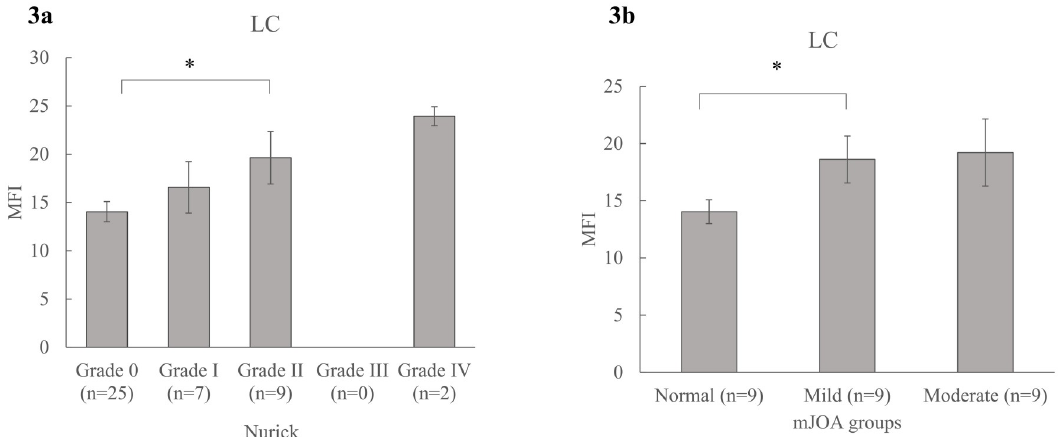
Fig 3. Association between MFI and clinical scores. Mean group differences in MFI across varying severity of clinical disability in patients with DCM as measured by a) Nurick (Grade 0—IV), and b) mJOA groups (Normal = 18, Mild = 17–15, and moderate = 14– 12). Mean (SE) are reported. � denotes significance at p � 0.05. MFI = muscle fat infiltration, LC = longus colli and longus capitis, mJOA = modified Japanese Orthopedic Association.